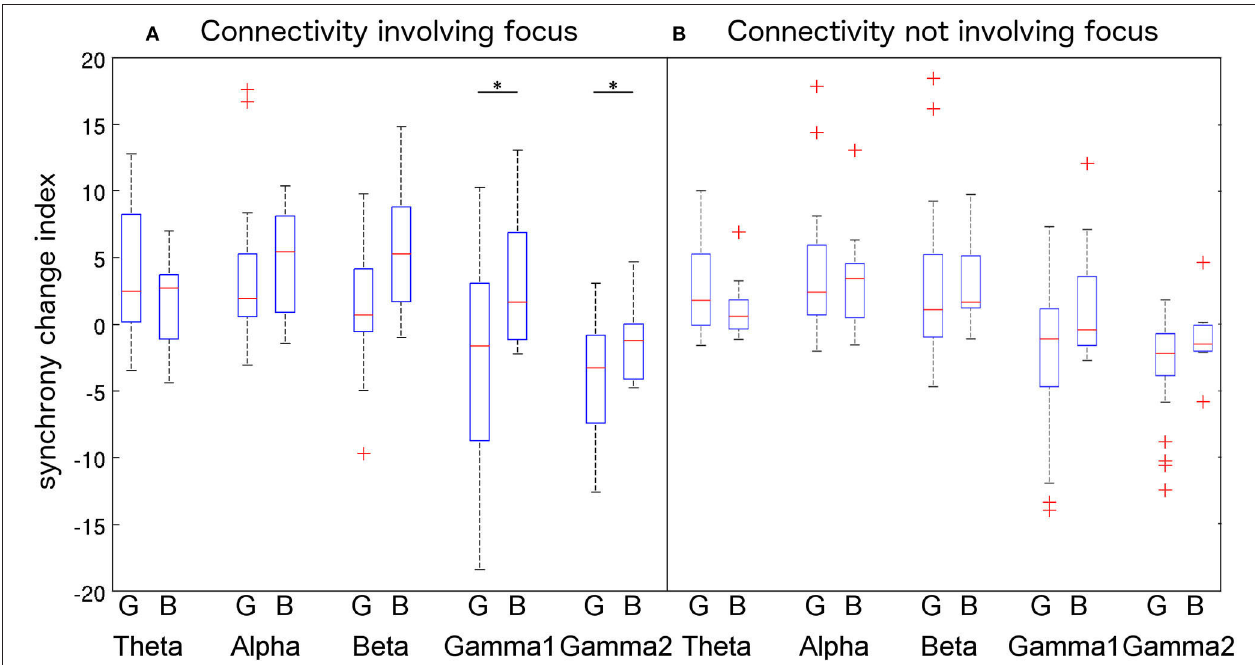
FIGURE 5 | Comparison of PLV variations among the (good outcome—G vs. bad outcome—B) patients groups for each frequency band using a 2-way ANOVA. Connectivity involving the epileptic focus (F-F, F-P, and F-S connections, A ) increases in lower frequency bands and decrease in higher frequency bands. Differences between patients groups reach significance at the 5% level for gamma1 and gamma2 bands. Connectivity not involving the focus (P-P, P-S, and S-S, B ) shows similar trends but differences were not significant. Outliers are represented with a “ + ” symbol. Significant differences are represented with a “*”